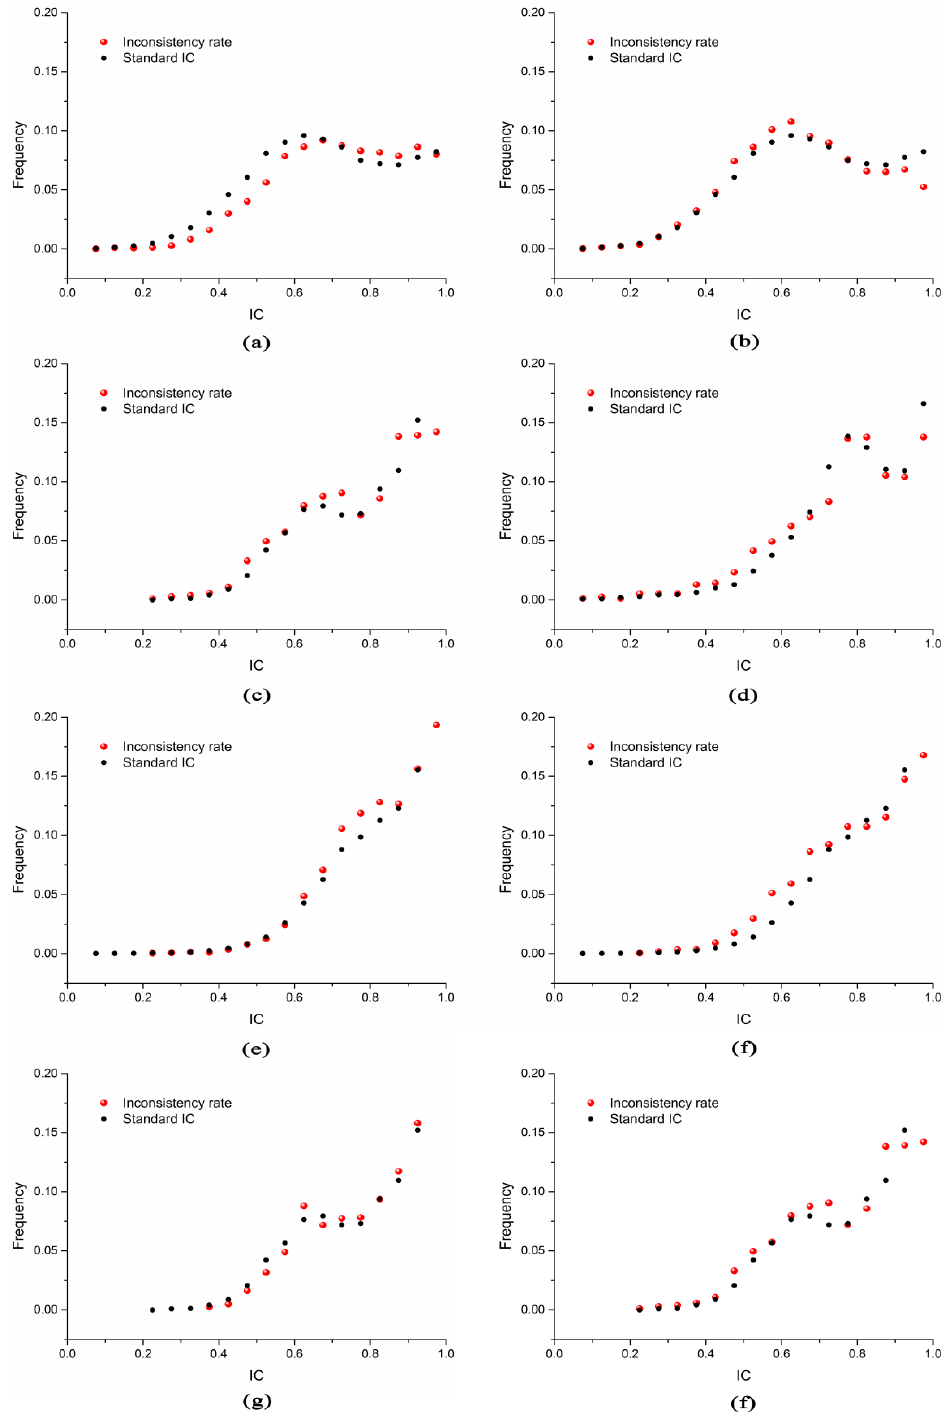
Figure 11. Inconsistency rate distribution histogram with different tree species before and after topographic correction. (a) Pine before correction, (b) Pine corrected by the SCS+C model, (c) Chinese arborvitae before correction, (d) Chinese arborvitae corrected by the SCS+C model, (e) Oak before correction, (f) Oak corrected by the SCS+C model, (g) Black locust in SR data and (h) Black locust corrected by the SCS+C model.